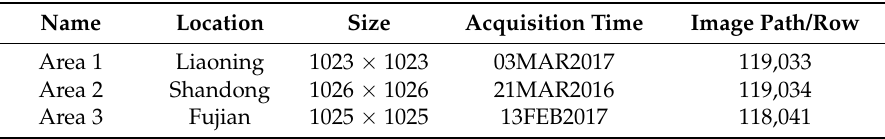
Table 1. Introduction to the experimental